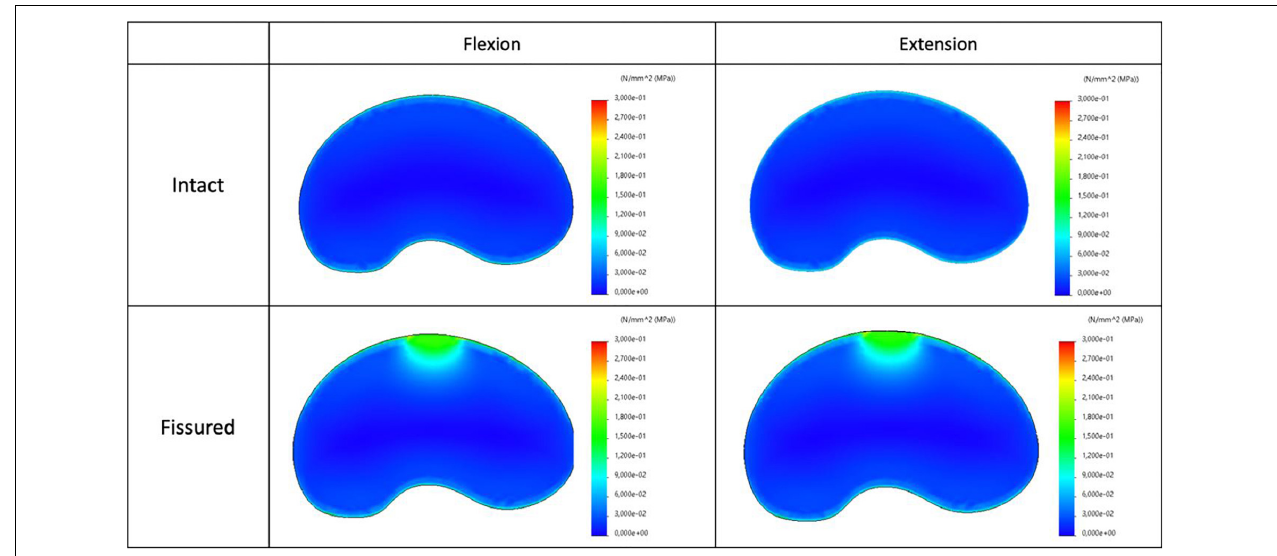
FIGURE 8 | Distribution of the intensity of maximal shear stress for intact (top) and fissured (bottom) disc with flexion (left) and extension (right)